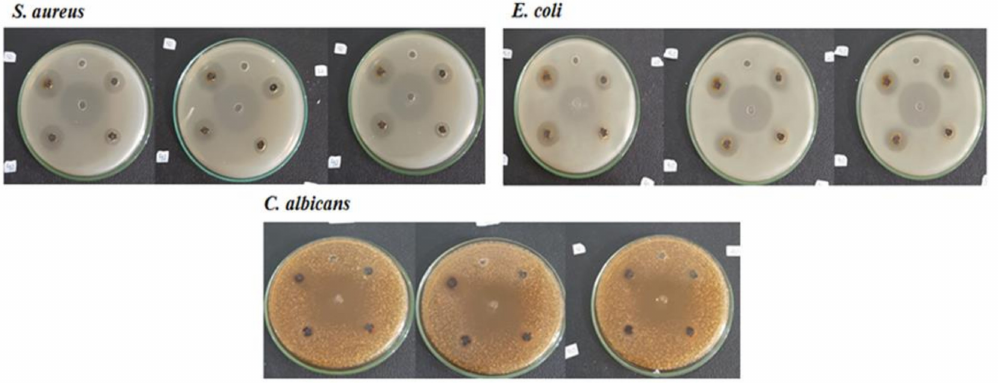
Figure 8. Antimicrobial activity of AgNP-chi-spheres against S. aureus , E. coli , and C. albicans after 24 h of incubation time.